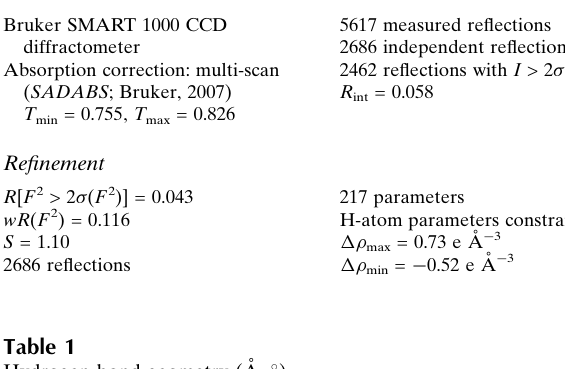
Hydrogen-bond geometry (A˚ , (cid:2)